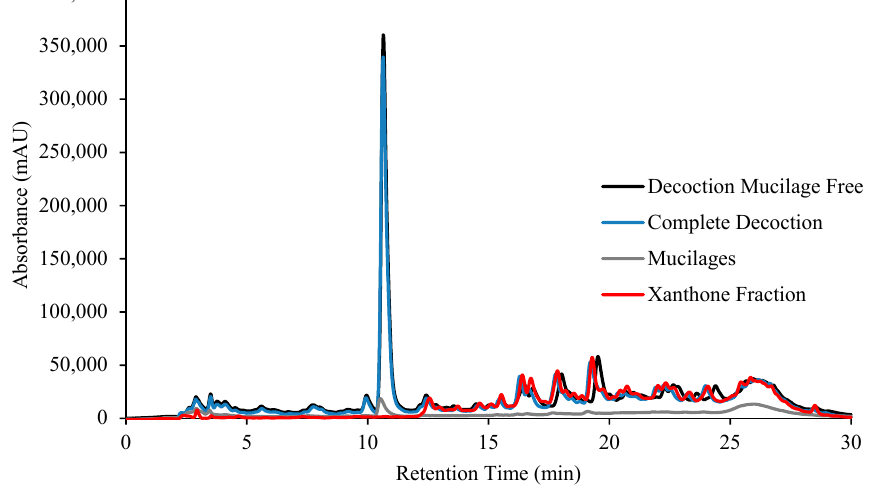
Figure 1. Reversed-phase high-performance liquid chromatography with diode array detector (RP-HPLC–DAD) chromatogram of decoction of C. erythraea and its isolated fractions.